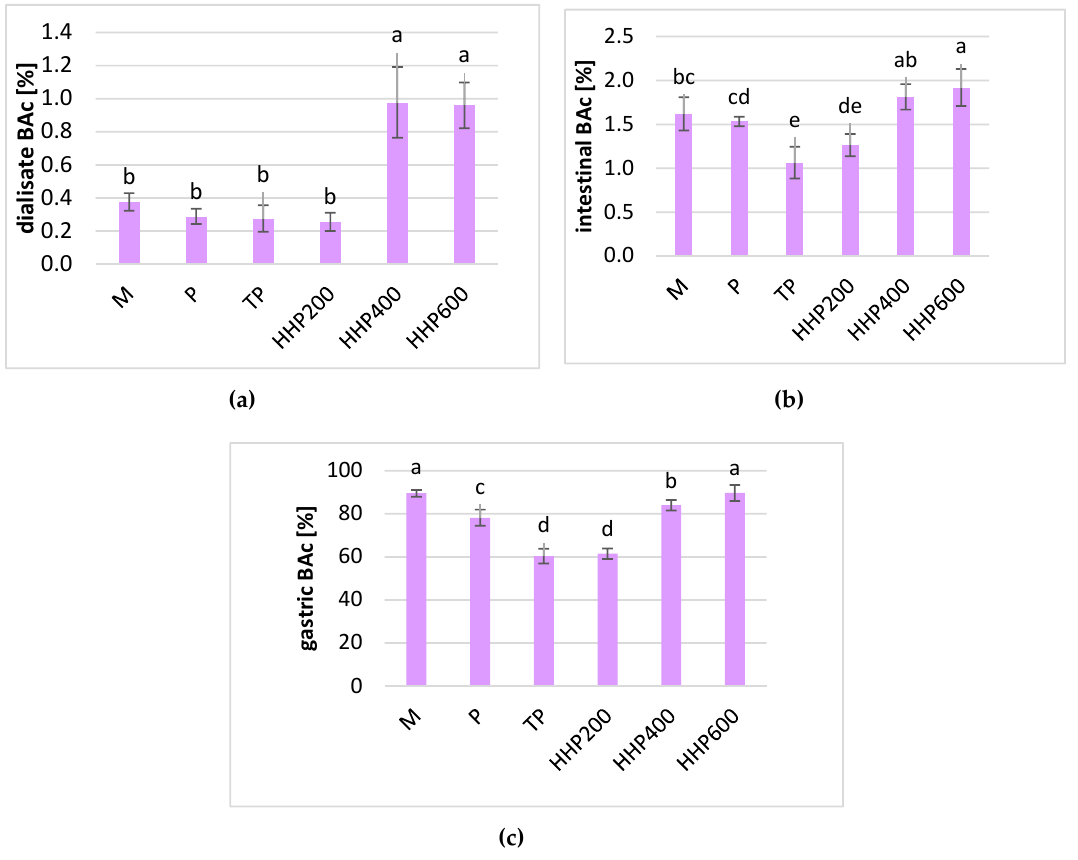
Figure 2. Relative bioaccessibility of total anthocyanins in blackcurrants after different processing: M–crushed in a mortar; P–untreated puree; TP–thermal-treated puree; HPP200–high-pressured puree at 200 MPa; HPP400–high-pressured puree at 400 MPa; HPP600–high-pressured puree at 600 MPa; ( a ) in the dialysate stage; ( b ) in the intestinal stage; ( c ) in the gastric stage; small letters a–d indicate statically significant differences in the mean values between samples at a confidence level of α = 0.05